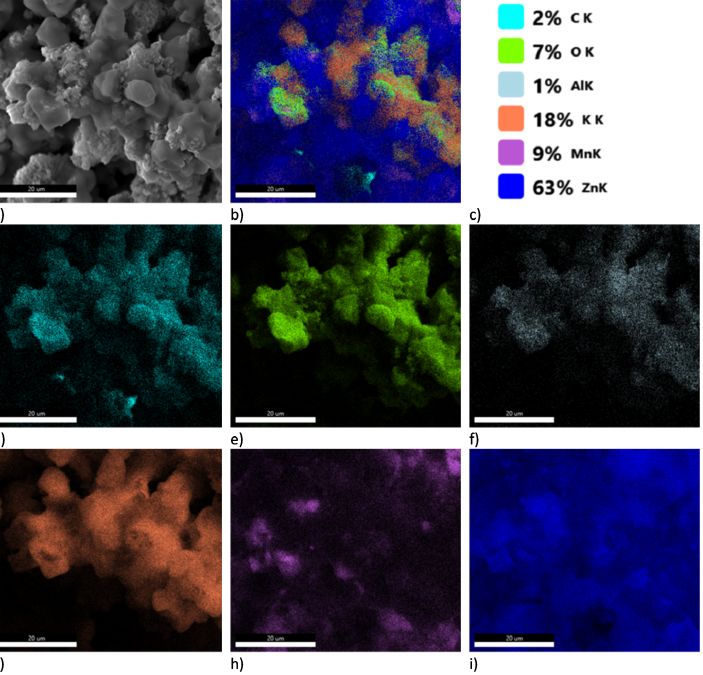
Figure A6. Result of SEM-EDS analysis for sample Zn6. ( a )—SEM picture; ( b )—EDS map; ( c )— weight concentration %; ( d )—EDS map for C; ( e )—EDS map for O; ( f )—EDS map for Al; ( g )—EDS map for K; ( h )—EDS map for Mn; ( i )—EDS map for